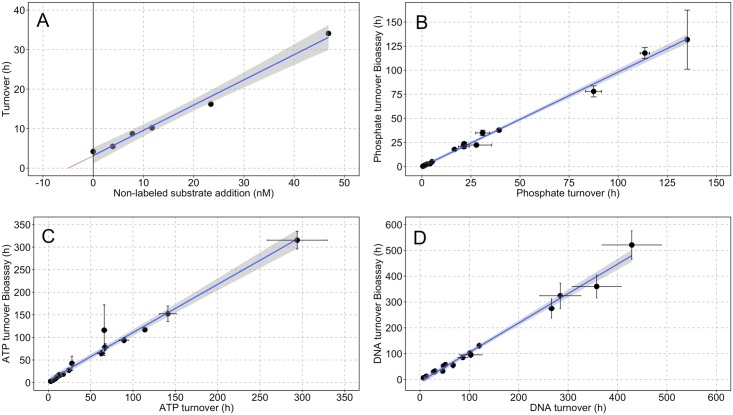
Radioactive bioassay concentration series.Panel (A) provides an example of the Rigler bioassay approach [78] using 33PO43- uptake data from 04.04.2012. The turnover of 33PO43- (T0) was measured over a concentration series of non-labeled substrate additions (Sa). The Lineweaver-Burk plot showed here is a linear representation of Michaelis-Menten uptake kinetics, whereby the slope of the regression (1/Vmax) provides an estimate of substrate uptake rate, the negative intercept on the x-axis (k + Sn: red line) is an estimate of the natural substrate concentration (Sn) at ambient conditions (Sa = 0), where k is the transport constant and assumed to be negligibly small [79], and the y-intercept is substrate turnover (k + Sn / Vmax) at zero added substrate (Sa = 0). In the case of phosphate, k + Sn is taken as an estimate of biologically available phosphate and distinct from soluble reactive phosphorous (SRP) determined analytically. Panels (B-D) provide verification of the substrate uptake models by comparing (k + Sn / Vmax) with turnover rates (T0) measured from independent experiments. Error bars on measured turnover rates (x-axis) represent ± 1 σ from n = 3 replicates and error bars on bioassay estimates (y-axis) are estimated from the LINEST function of the concentration series (n>4). Regression statistics (slope ± standard error; p-value; r2; F-statistic; degrees of freedom, p-value) for 33PO43- (1.01 ± 0.02; <0.001; 1.00; 2561; <0.001), AT33P (0.96 ± 0.01; <0.001; 1.00, 1.08 x 104; 16, <0.001) DNA-33P (1.02 ± 0.04; <0.001; 0.98. 671.3; 16; 0.001).